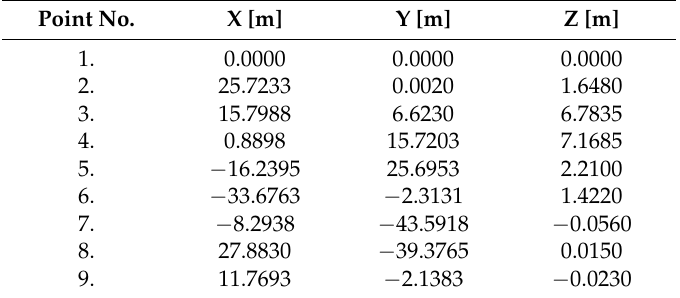
Table 9. Field surveying data with the levelled and centered instrument (Total Station). Point No.